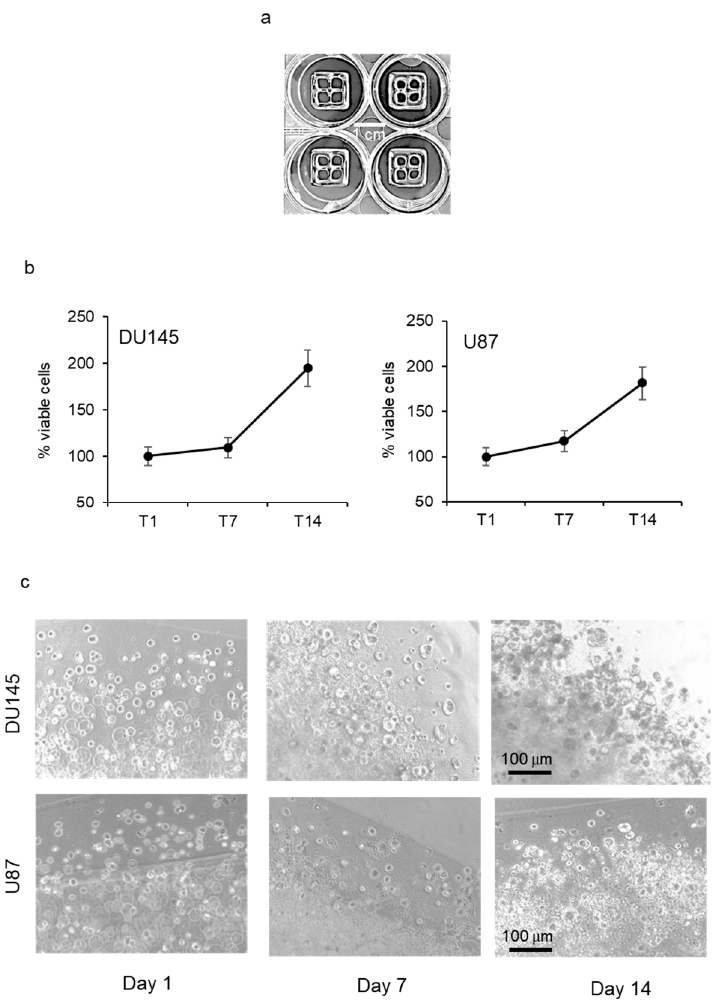
Figure 1. Tumor cell growth in bioprinted scaffold. ( a ) Exemplificative image of bioprinted algine/gelatin constructs printed in 12-well multiwell plate. ( b ) Mean percentage of viable DU145 and U87 cells grown in bioprinted scaffold and evaluated 1, 7, and 14 days (T1, T7, T14) after bioprinting. The mean values measured at T1 were adjusted at 100%. Each value represents the mean of five different bioprints ( ± standard deviation). ( c ) Representative images acquired by phase contrast microscopy (100 × magnification) of bioprints containing DU145 (upper images) and U87 cells at days 1, 7, and 14 after